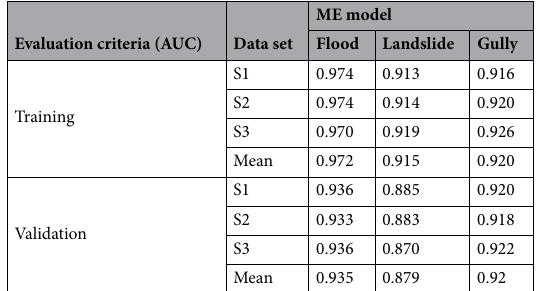
Evaluation criteria